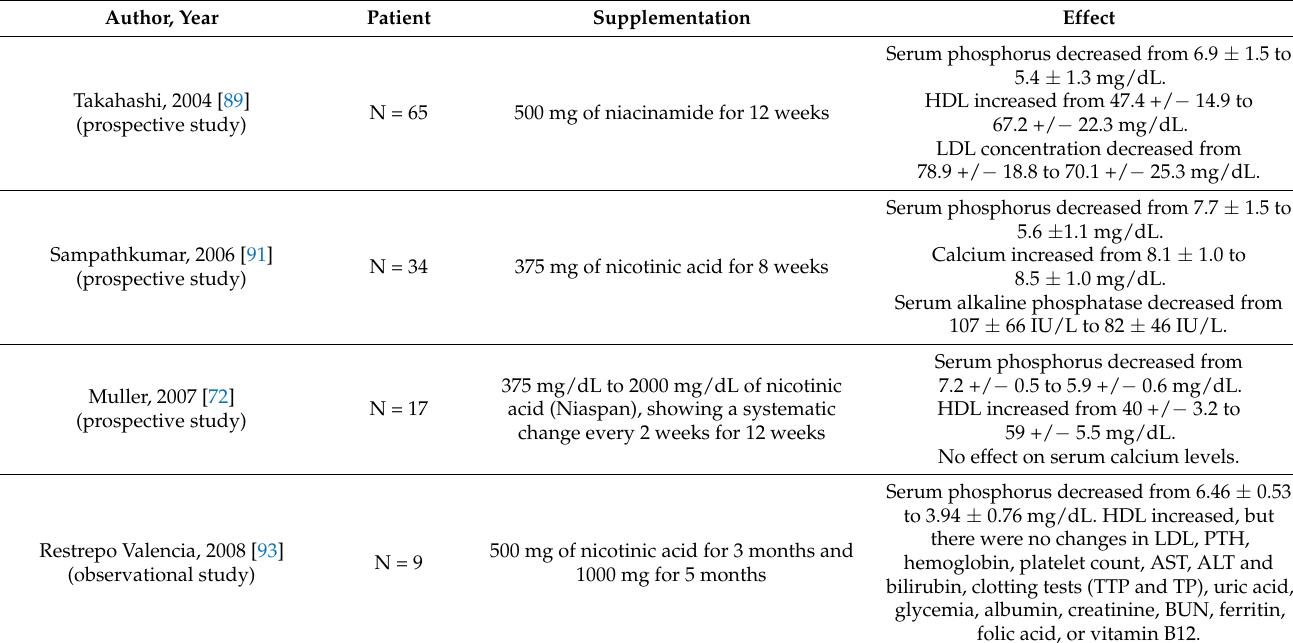
Table 3. Studies on niacin supplementation in